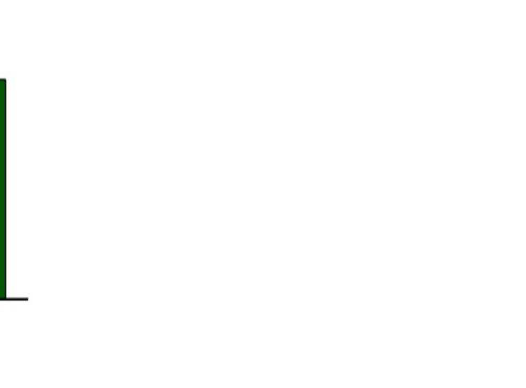
Figure 1. Effects of N application on chlorophyll content index in early flowering. Different letters on the top of the bars indicate significant difference at p < 0.05 by Duncan.